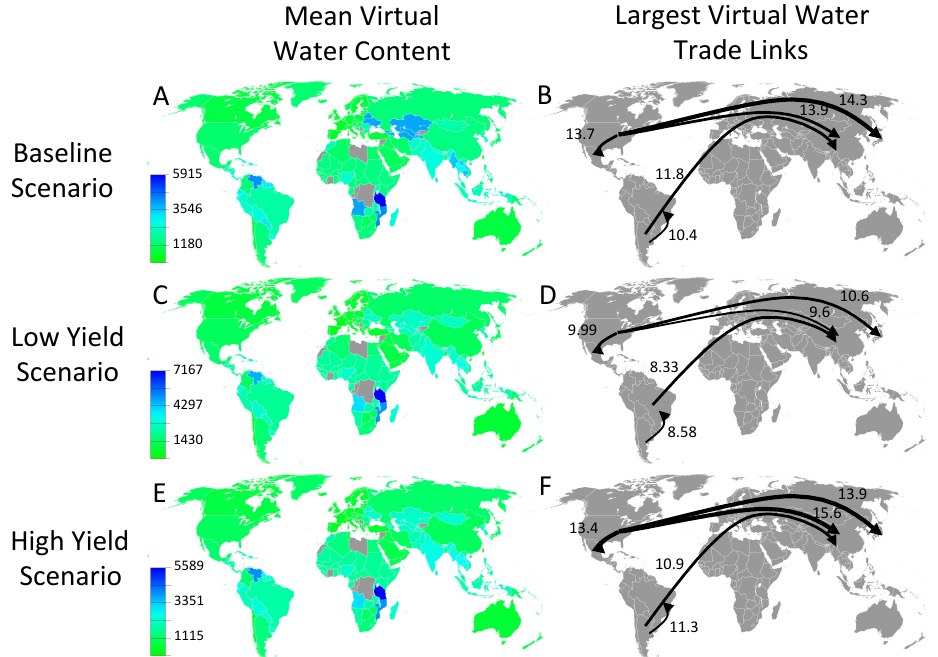
Fig. 4. Maps of VWC and the largest virtual water trade links by scenario. ( a, c, e ): maps of VWC averaged across crops. The color of each country illustrates the VWC (i.e., total evapotranspiration per unit of crop, [dimensionless]) of each country. Grey indicates countries without data. ( b, d, f ): the 5 largest links by virtual water volume [billions m 3 ] are provided in black. Note that the width of the arrows has been scaled according to the volume of virtual water traded along each link. The first row ( a, b ) illustrates the baseline scenario (i.e., 2001); the second row ( c, d ) illustrates the low-yield scenario; the third row ( e, f ) illustrates the high-yield scenario. All future climate change scenarios are for the year 2030.